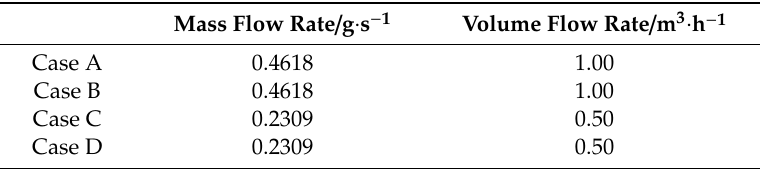
Table 2. Central gas set in each inlet